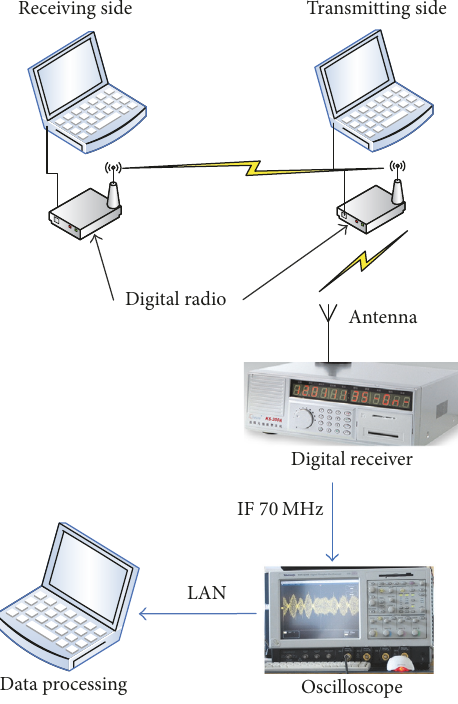
Figure 2: The scheme of experiment.